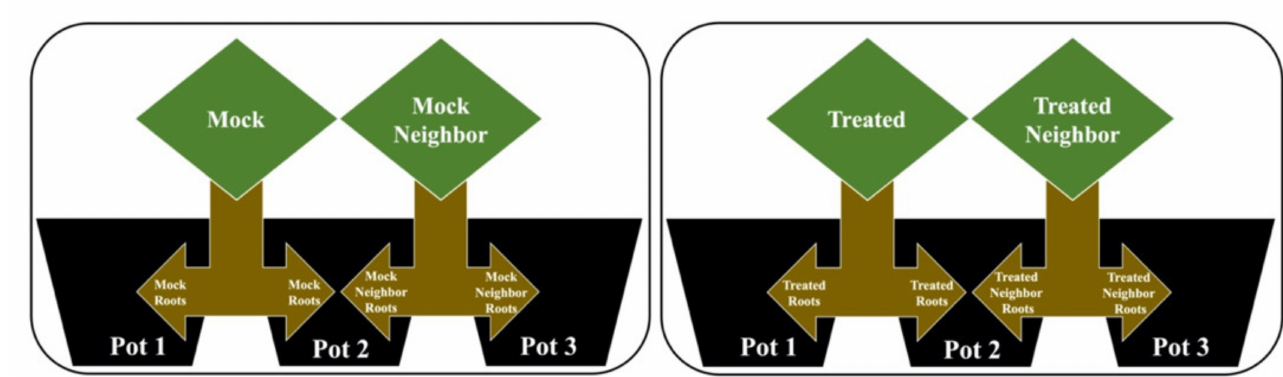
Figure 5. Experimental model for root communication following the model in [34,62]. The mock group had their roots divided and allocated to pots 1 and 2; the mock neighbor group had their roots divided and allocated to pots 2 and 3; the treated group had their roots divided and allocated to pots 1 and 2; the treated neighbor group had their roots divided and allocated to pots 2 and